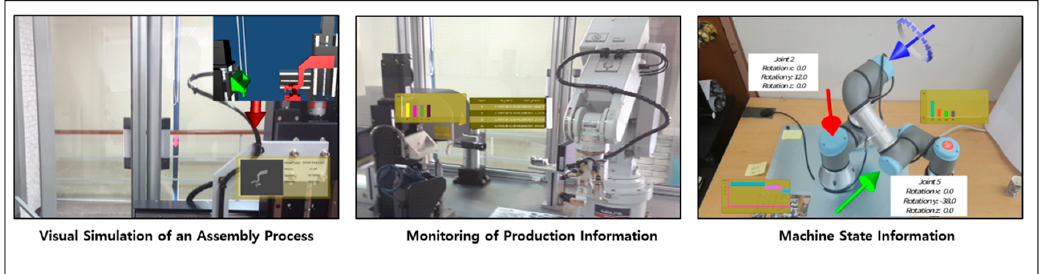
Figure 1. Visual and interactive assistance through wearable augmented reality (AR) applied to manufacturing services, such as visualization of the status of machines and robot.